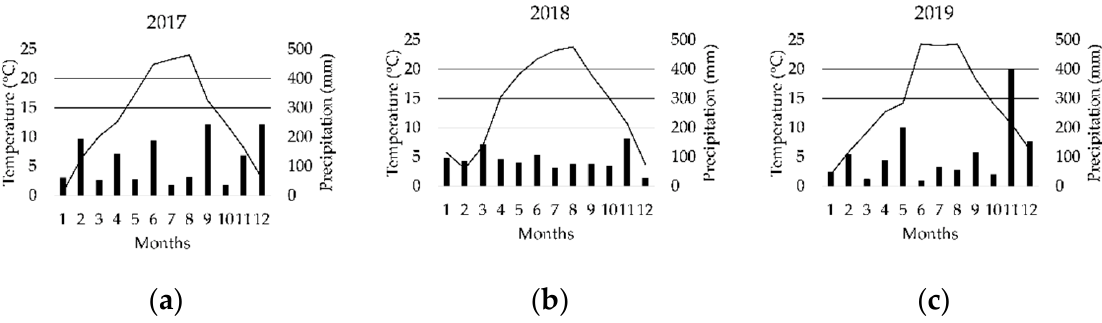
Figure 1. Average monthly air temperature (°C) (line) and precipitation (mm) (bars) at Vipava Valley in: ( a ) 2017, ( b ) 2018 and ( c ) 2019.